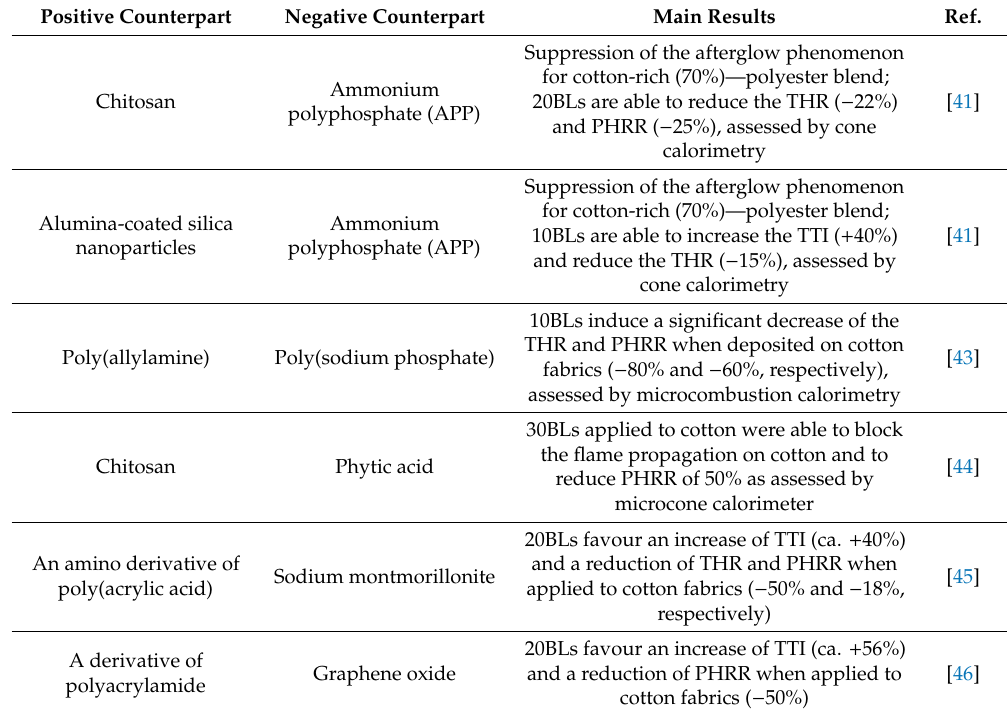
Table 4. Layer-by-Layer (LbL) inorganic / organic systems [9].